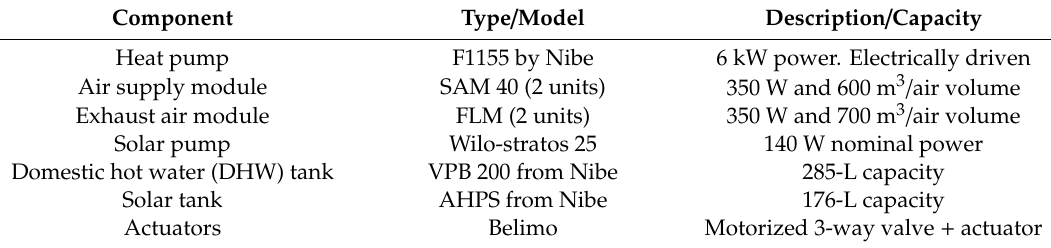
Table 1. Main components of the production system.